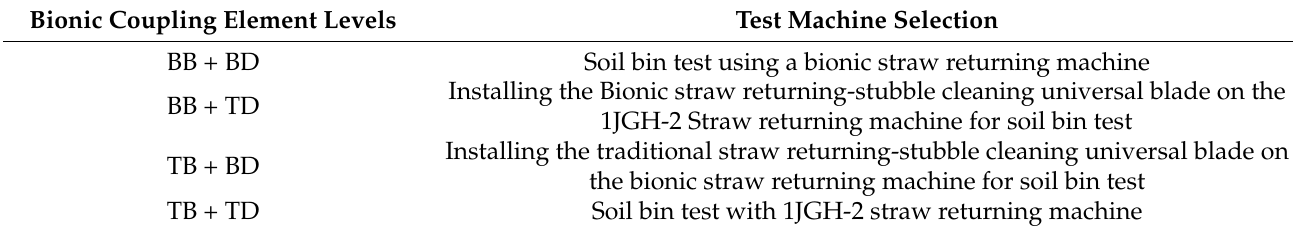
Table 1. Bionic coupling element level and the test machines comparison table.